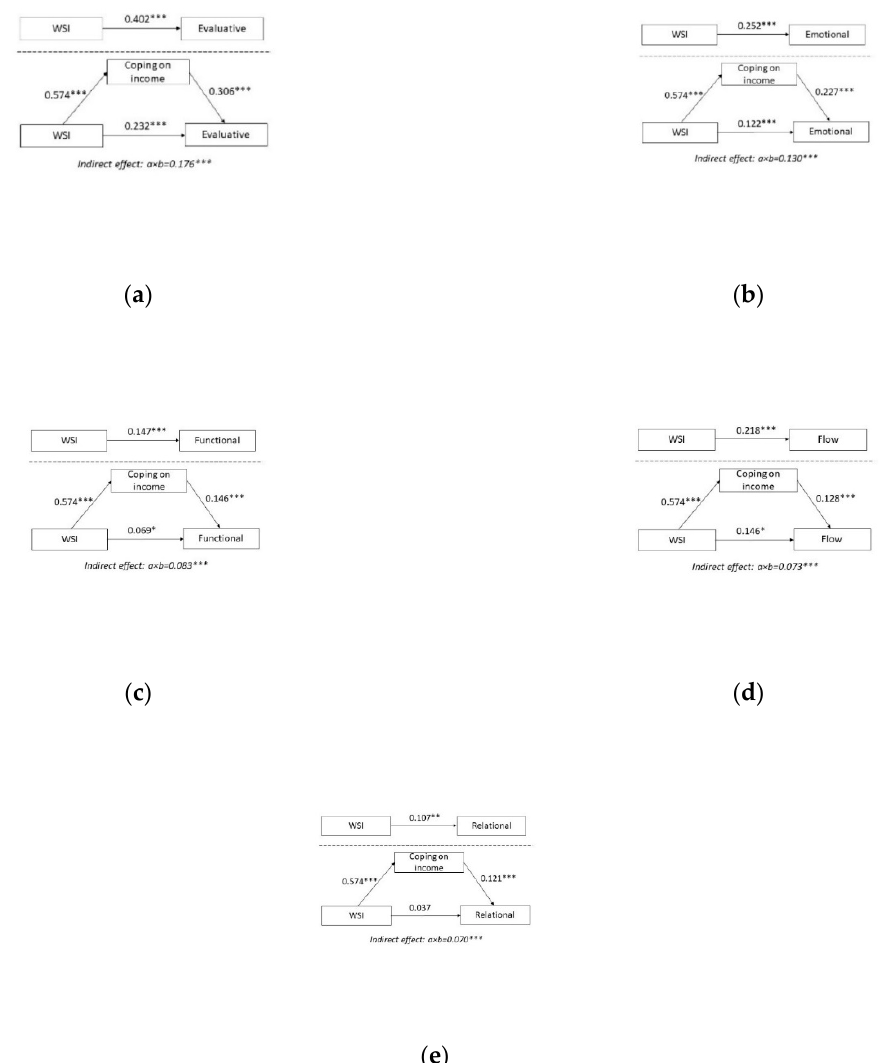
Figure 1. Subjective health intervening variable. ( a ) Evaluative dimension. ( b ) Emotional dimension. ( c ) Functional dimension. ( d ) Flow dimension. ( e ) Relational dimension. Significance level denoted by stars as follows: *** p < 0.001.